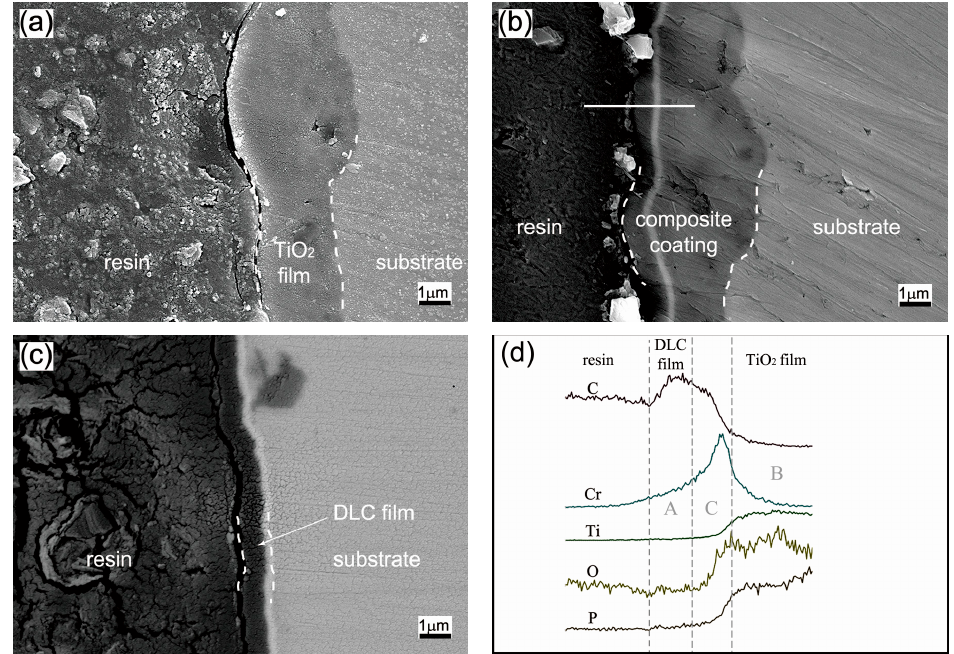
Figure 2. Cross-sectional morphologies and element analyses of coatings: ( a ) anodic TiO 2 film; ( b ) TiO 2 /DLC composite coating; ( c ) DLC mono-film; ( d ) element line-scanning analyses of the cross-sectional surface of TiO 2 /DLC composite coating.